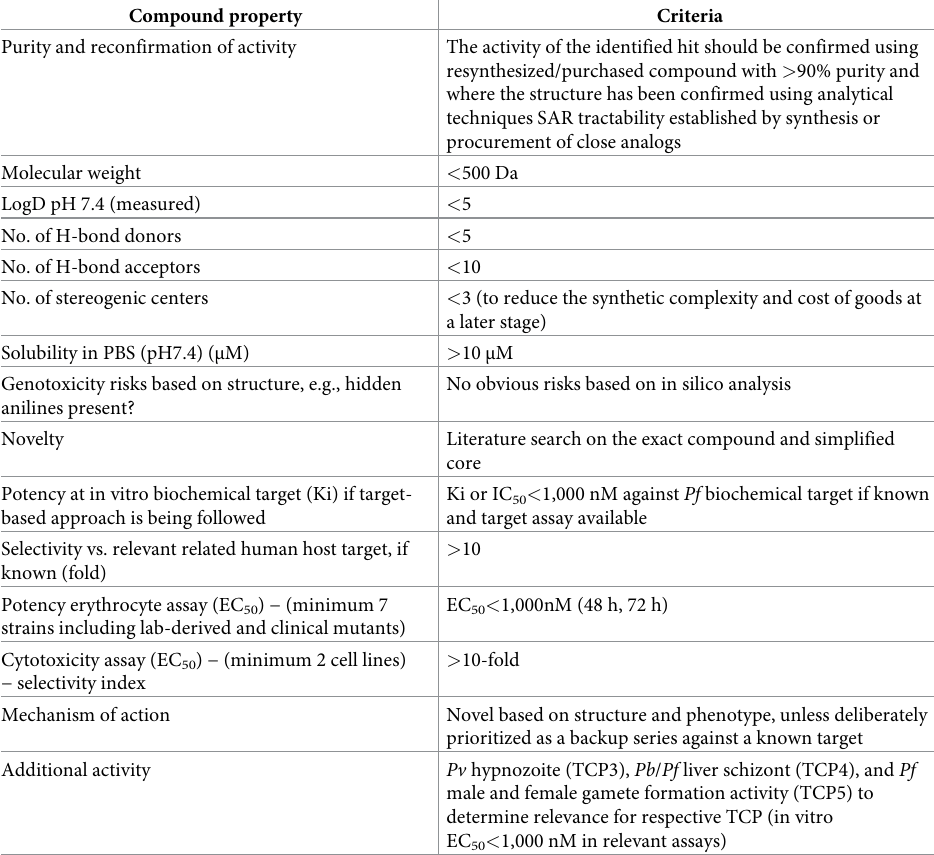
Table 2. Criteria for validated hit series for